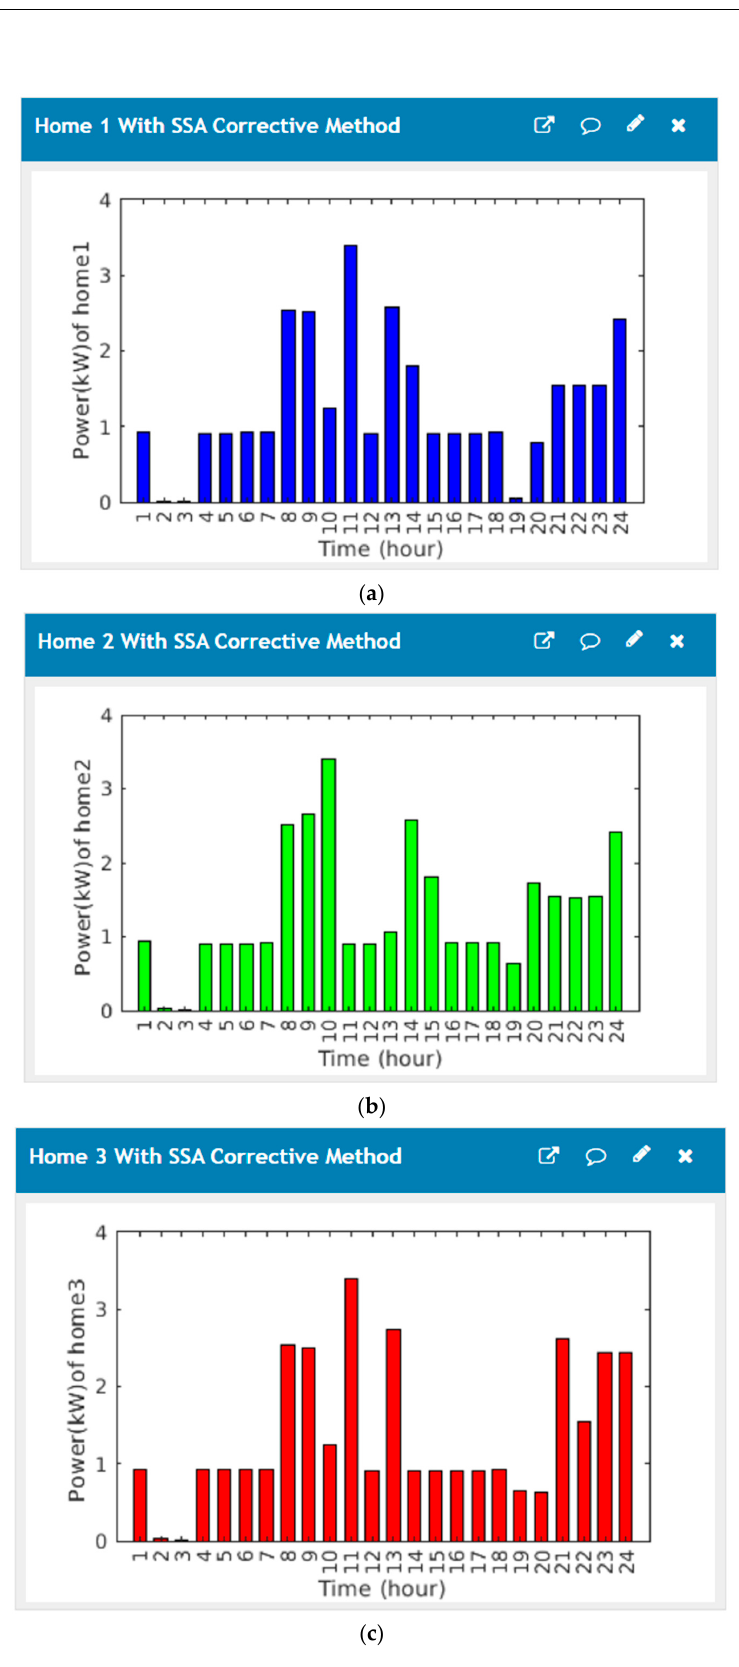
Figure 10. Power GUI of the proposed system after implementing the SSA algorithm: ( a ) load profiles of first house; ( b ) load profiles of second house; ( c ) load profiles of third